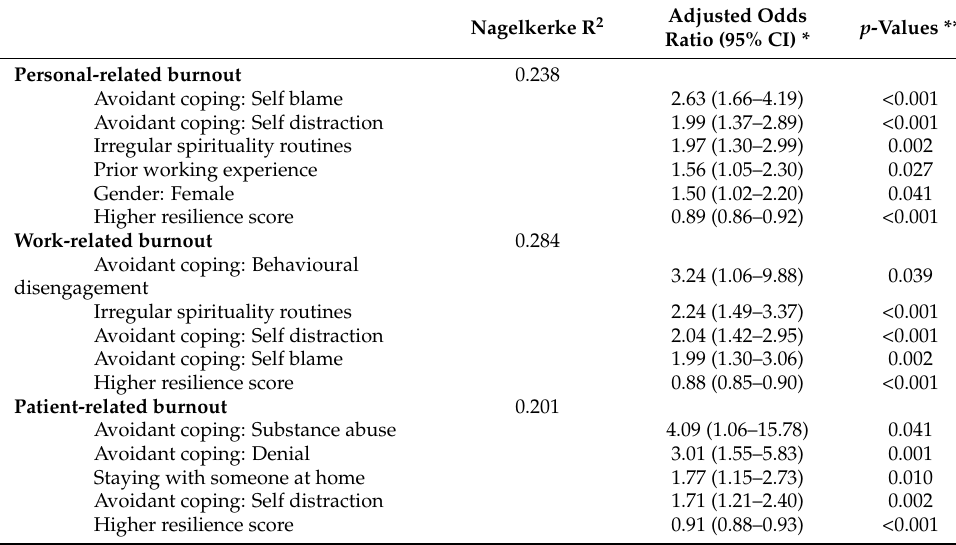
Table 4. Significant relationship between studied variables and burnout in a descending odds ratio as analyzed from binary logistic regression ( n =